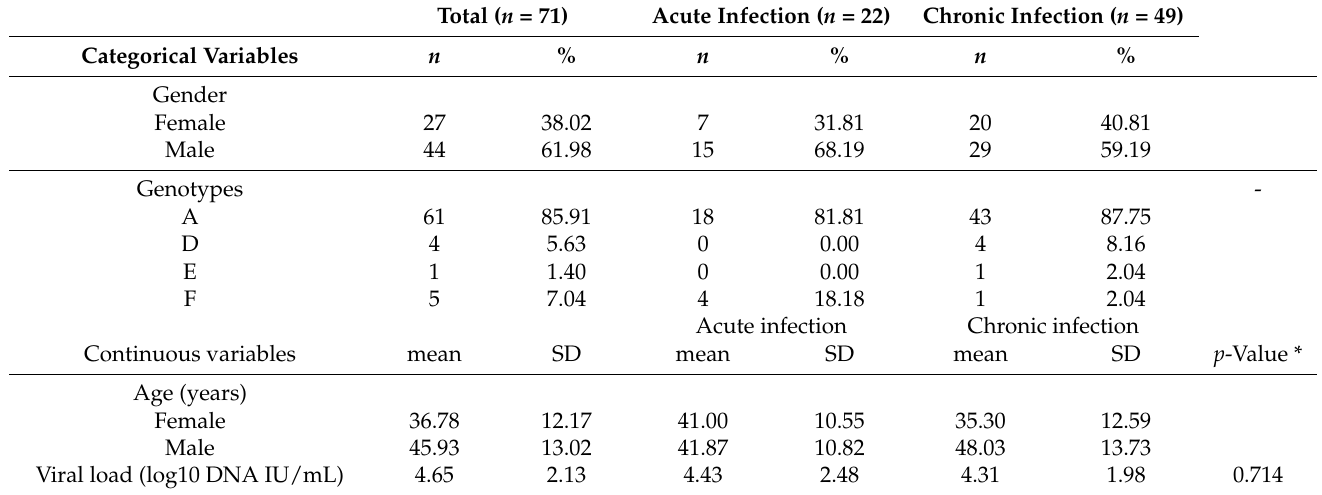
Table 1. Demographic, epidemiological, clinical, and genotypic characteristics of the population. Total ( n = 71) Acute Infection ( n = 22) Chronic Infection ( n =